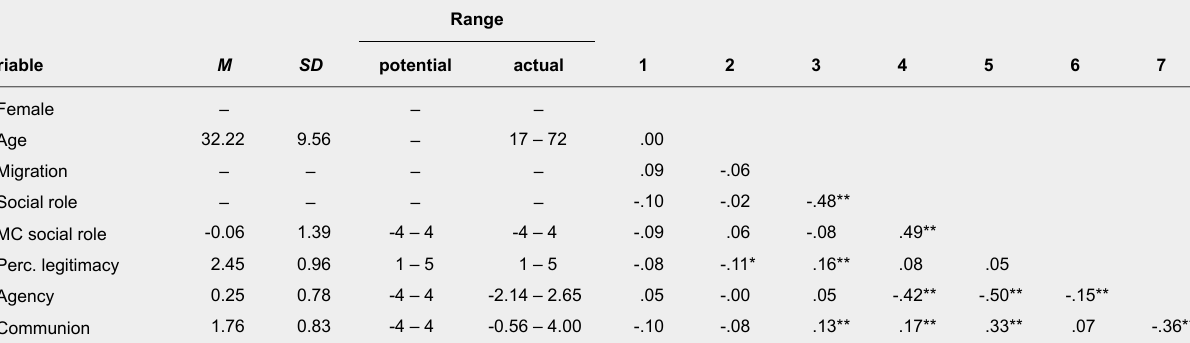
Descriptive Statistics and Bivariate Correlations Between the Independent and Main Dependent Variables Used in Study 1 (N = 391)